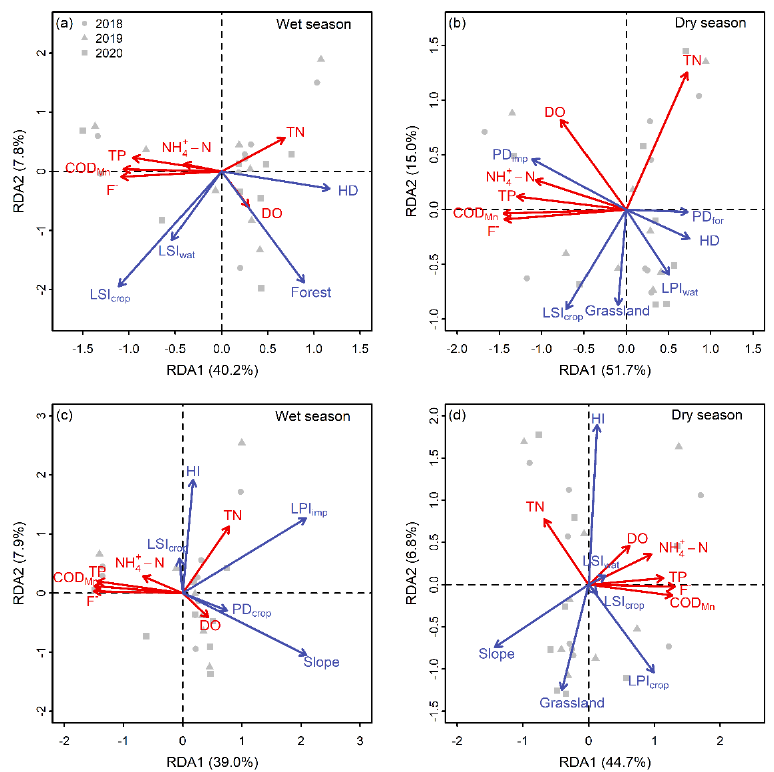
Figure 4. Ordination plots for the water quality variations at catchment ( a , b ) and buffer ( c , d ) scale in two seasons with landscape metrics as constraining variables. Abbreviations: COD Mn , chemical oxygen demand; DO, dissolved oxygen; TN, total nitrogen; NH + -N, ammonia nitrogen; F − , fluoride; 4 TP, total phosphorus; Forest and Grassland, the proportion of forest area and grassland area, respectively; Slope, regional slope; HD, regional relief; HI, hypsometric integral; PD crop , PD for , PD imp , patch density of cropland, forest and impervious layer, respectively; LSI crop and LSI wat , landscape shape index of cropland and water area, respectively; LPI crop , LPI wat , and LPI imp , largest patch index of cropland, water area and impervious layer, respectively.